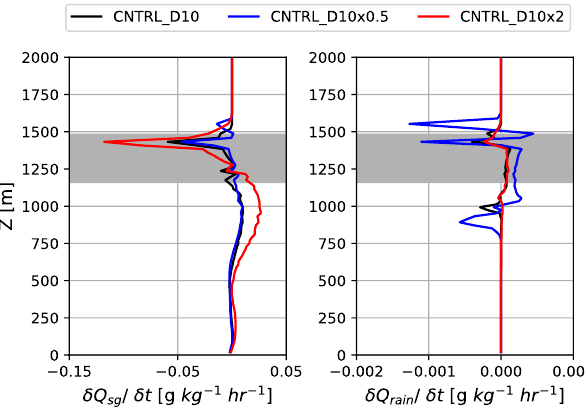
Figure 8. Microphysical tendencies comparison of CNTRL_D10, CNTRL_D10x0.5, and CNTRL_D10x2. Vertical profiles, at 9h, of solid precipitation (snow + graupel) mass tendency ( δQ sg /δt ) and rain mass tendency ( δQ rain /δt ) are shown. Area in grey represents CNTRL_D10 cloudy